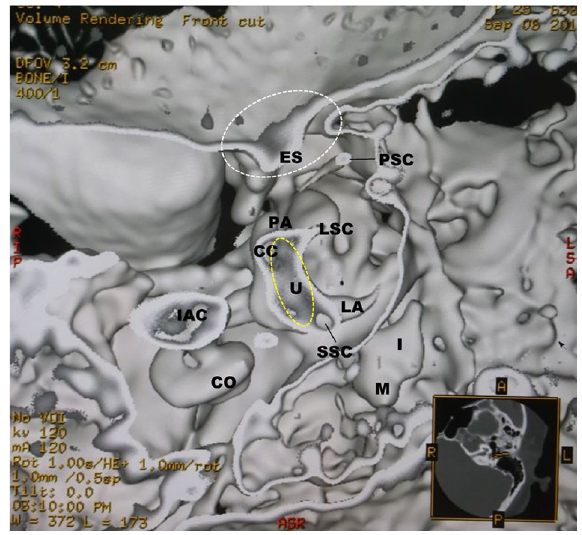
Figure 4. BPPV in a 25-year-old female. In the axial view, the irregularly shaped utricular macula (yellow dotted oval) is seen as a gray tissue extending from near the exit of the superior semicircular canal to the partial exit of the common crus. The endolymphatic sac (white dotted oval) and the cerebellopontine angle cistern show the gray tissue similar to the color of the utricular macula (yellow dotted oval). U utricular macula (yellow dotted oval), PA posterior ampulla, PSC posterior semicircular canal, PA posterior ampulla, LA lateral ampulla, LSC lateral semicircular canal, SSC superior semicircular canal, CC common crus, ES endolymphatic sac (white dotted oval), CO cochlea, IAC internal auditory canal, M malleus, I incus.